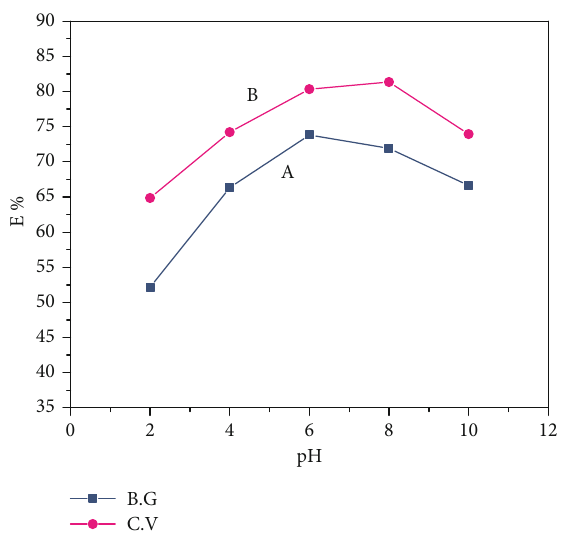
Figure 7: Impact of the solution ’ s pH on the sorption percentage of B.G. (a) and C.V. (b) dyes from aqueous solutions onto ( 0 : 005 ± 0 : 002 g ) the binary P3NT/30%AgTiO of stirring at 22 ± 0 : 1 ° C .